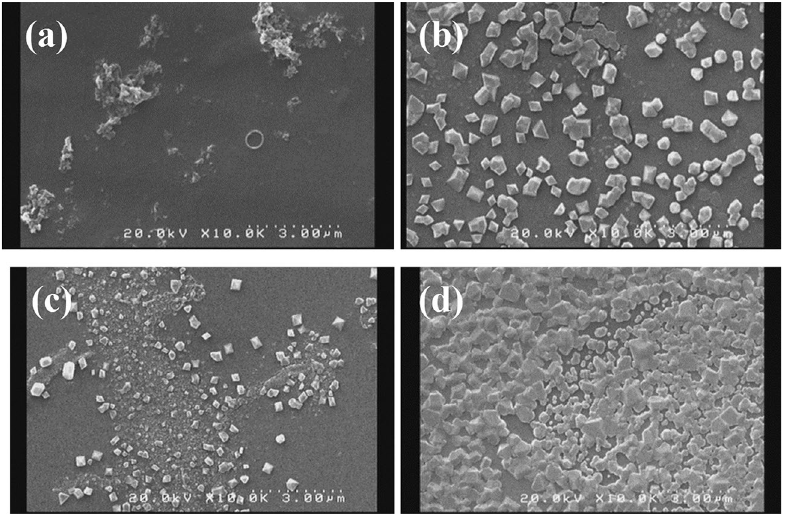
Figure 9. SEM images of TON coated by gelatin with and without GO soaking in SBF solution for different times (a) TON-Gel for 3 days (b) TON-Gel-GO for 3 days, (c) TON-Gel for 7 days, and (d) TON-Gel-GO for 7